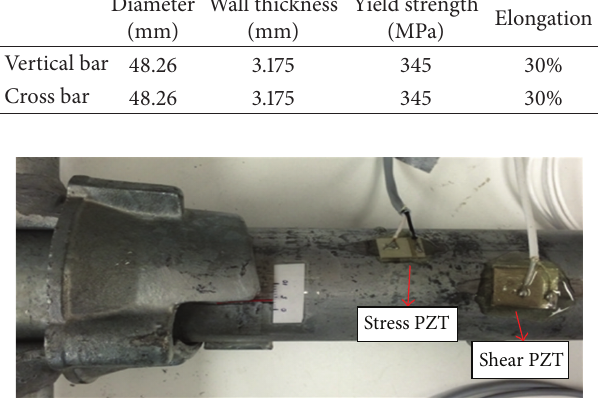
Figure 7: Picture of tightness scale and mounted stress PZT and shear PZT.